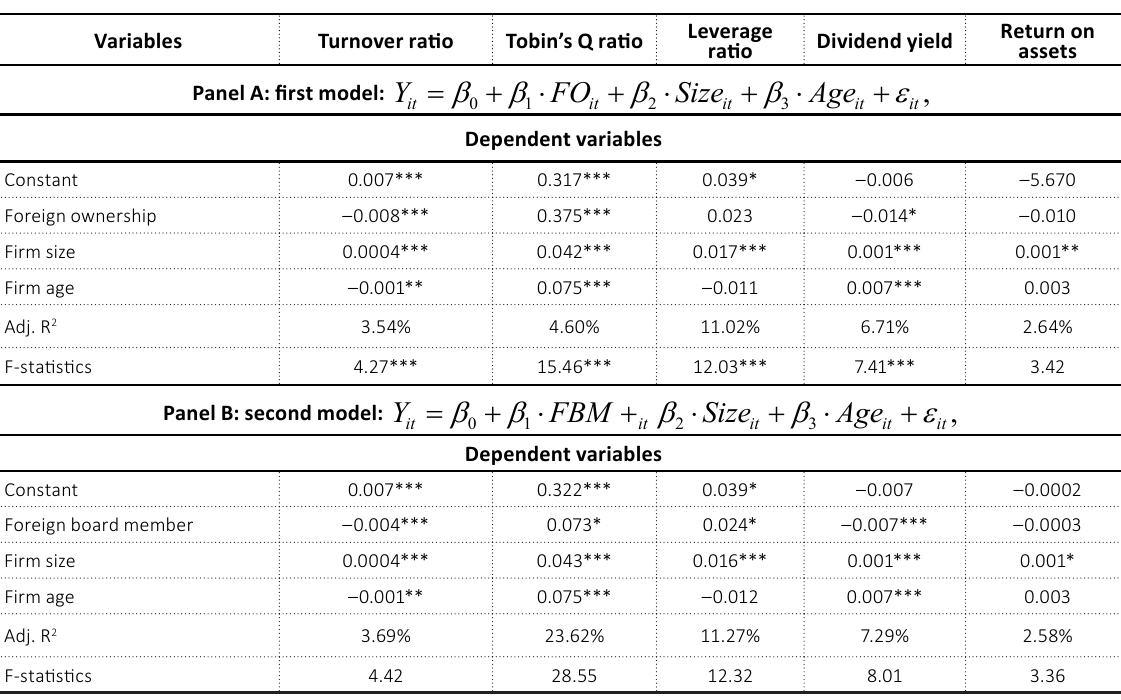
Table 5. Results based on fixed effect